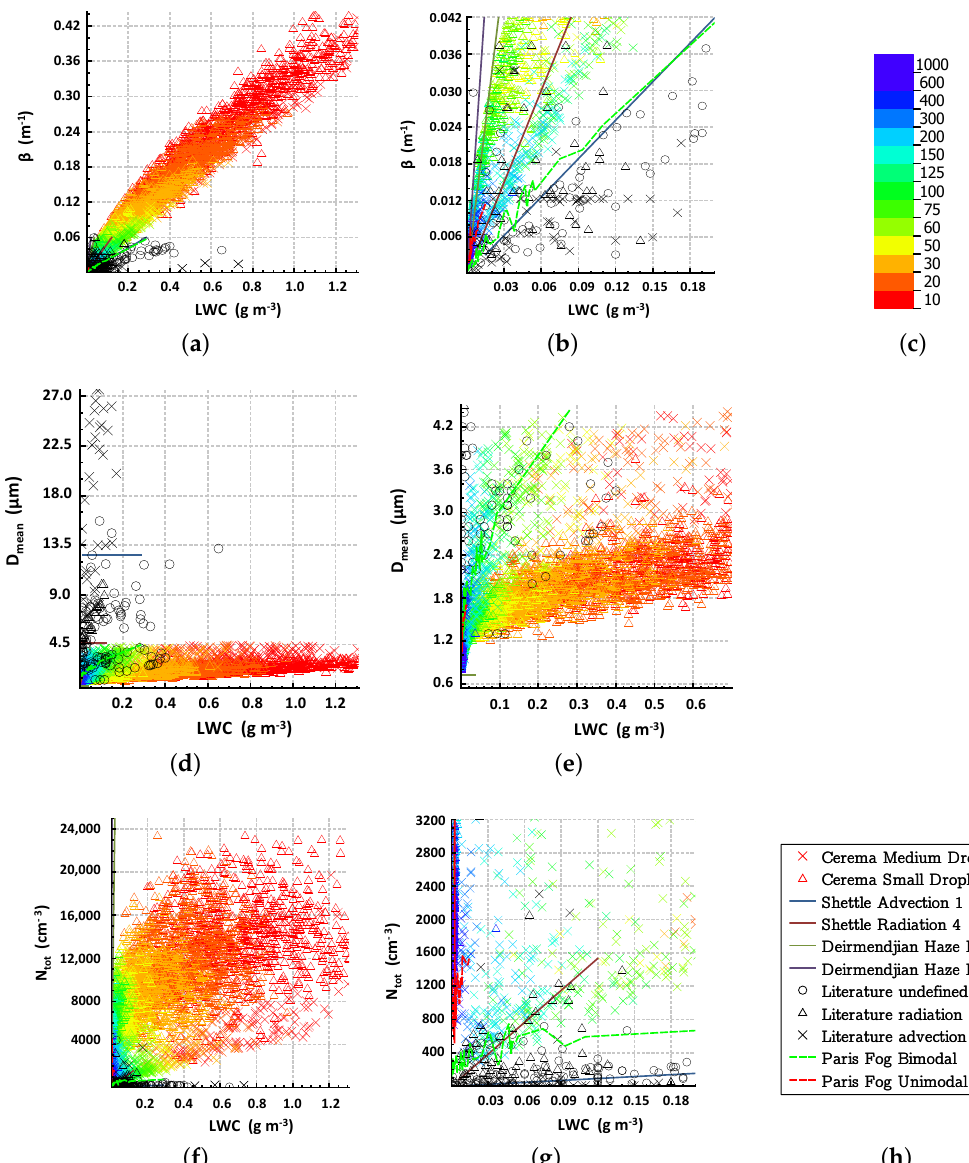
Figure 7. Cerema data and state of the art parameters. ( a ) β vs. LWC . ( b ) β vs. LWC zoom. ( c ) MOR color bar (m). ( d ) D mean vs. LWC . ( e ) D mean vs. LWC zoom. ( f ) N tot vs. LWC . ( g ) N tot vs. LWC zoom. ( h )